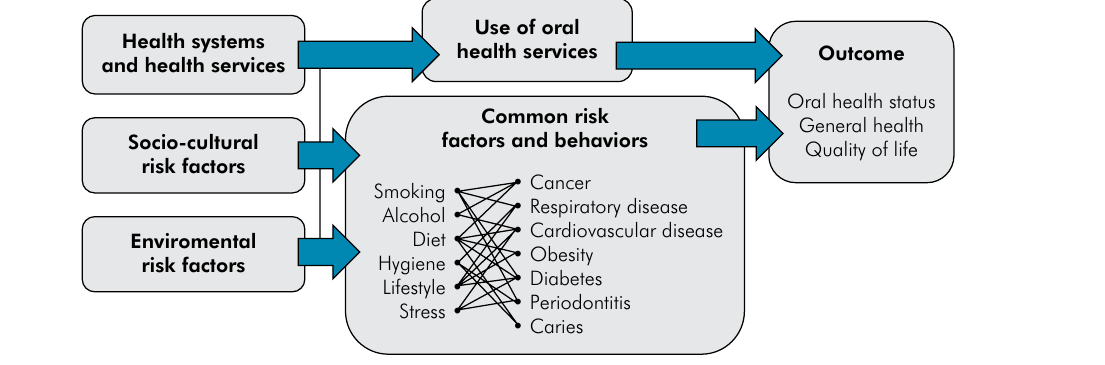
Figure 2. Risk factor approach in promotion of oral health. Adapted from Sheiham and Watt 15 and WHO. 16